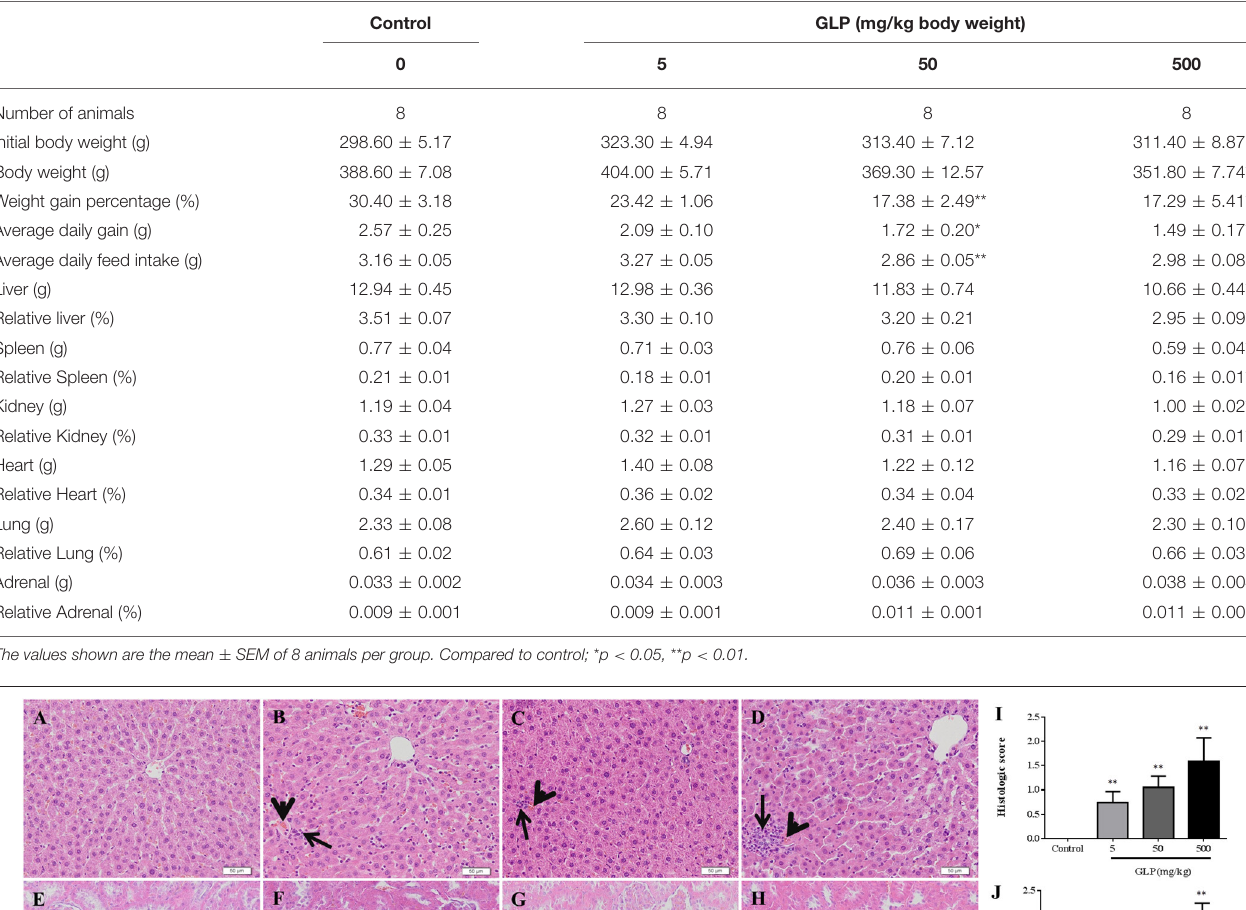
TABLE 2 | Body weights and organ weights of rats treated with Glyphosate for 5 weeks.